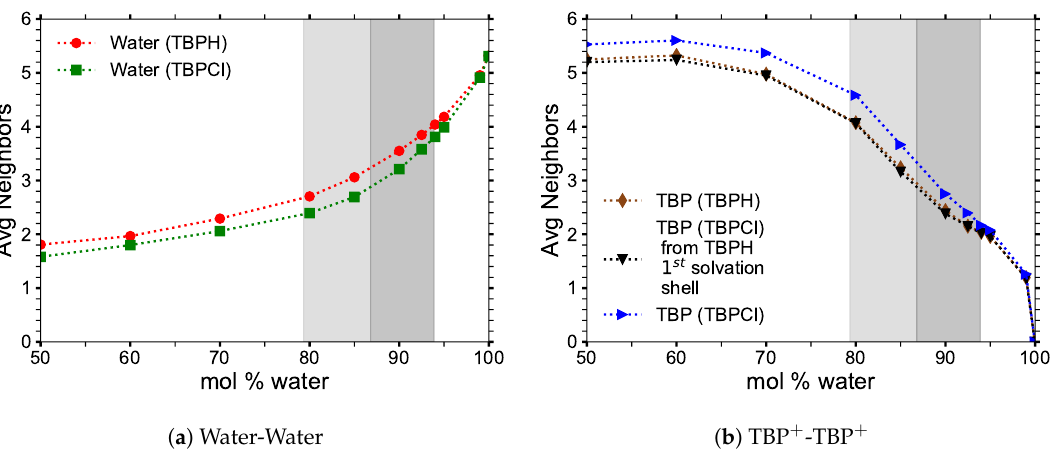
Figure 6. Average number of nearest molecularly identical neighbors in the largest cluster at 300K: ( a ) the average number of waters that neighbor a water molecule; ( b ) the average number of TBPs that neighbor a TBP